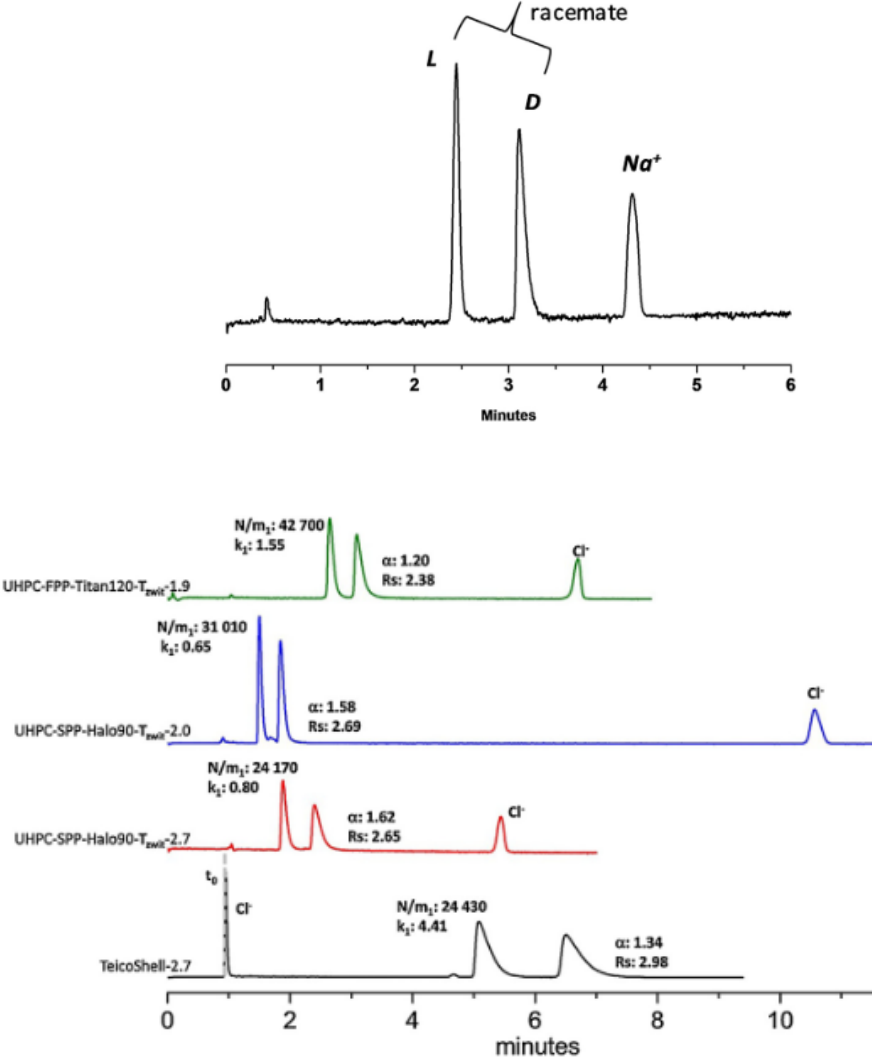
Figure 4. ( Top ) Direct gradient separation of D , L -Carglumic acid sodium salt on UHPC-Titan120- TCOOH-1.9 column. ( Bottom ) Separation of Propionyl- D , L -carnitine hydro-chloride on UHPC- Titan120-TZWIT-1.9 column. Comparison with commercially available column TeicoShell-2.7 and TZWIT SPP columns (packed with SPP 2.7 µ m, 2.0 µ m). Reproduced with permission [82] .